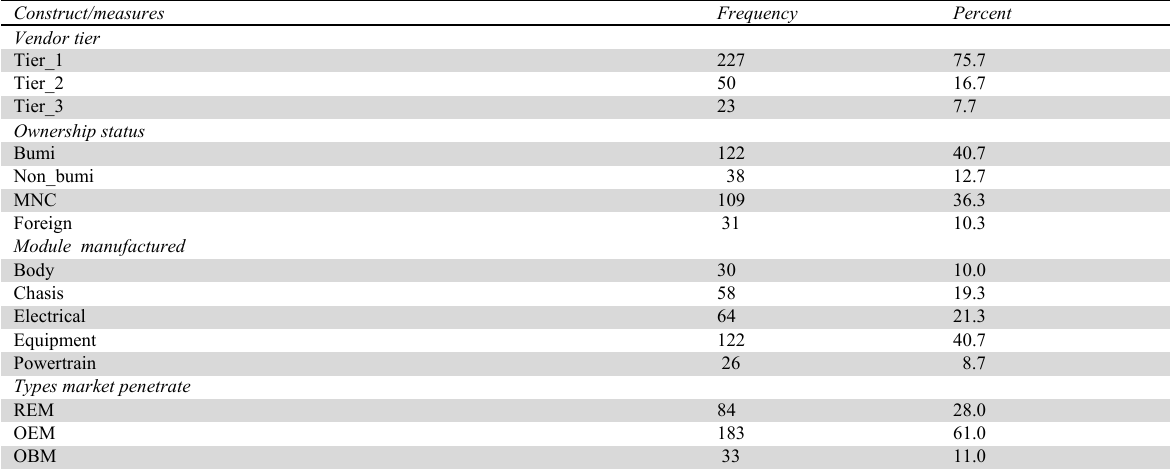
The profile respondents (n =